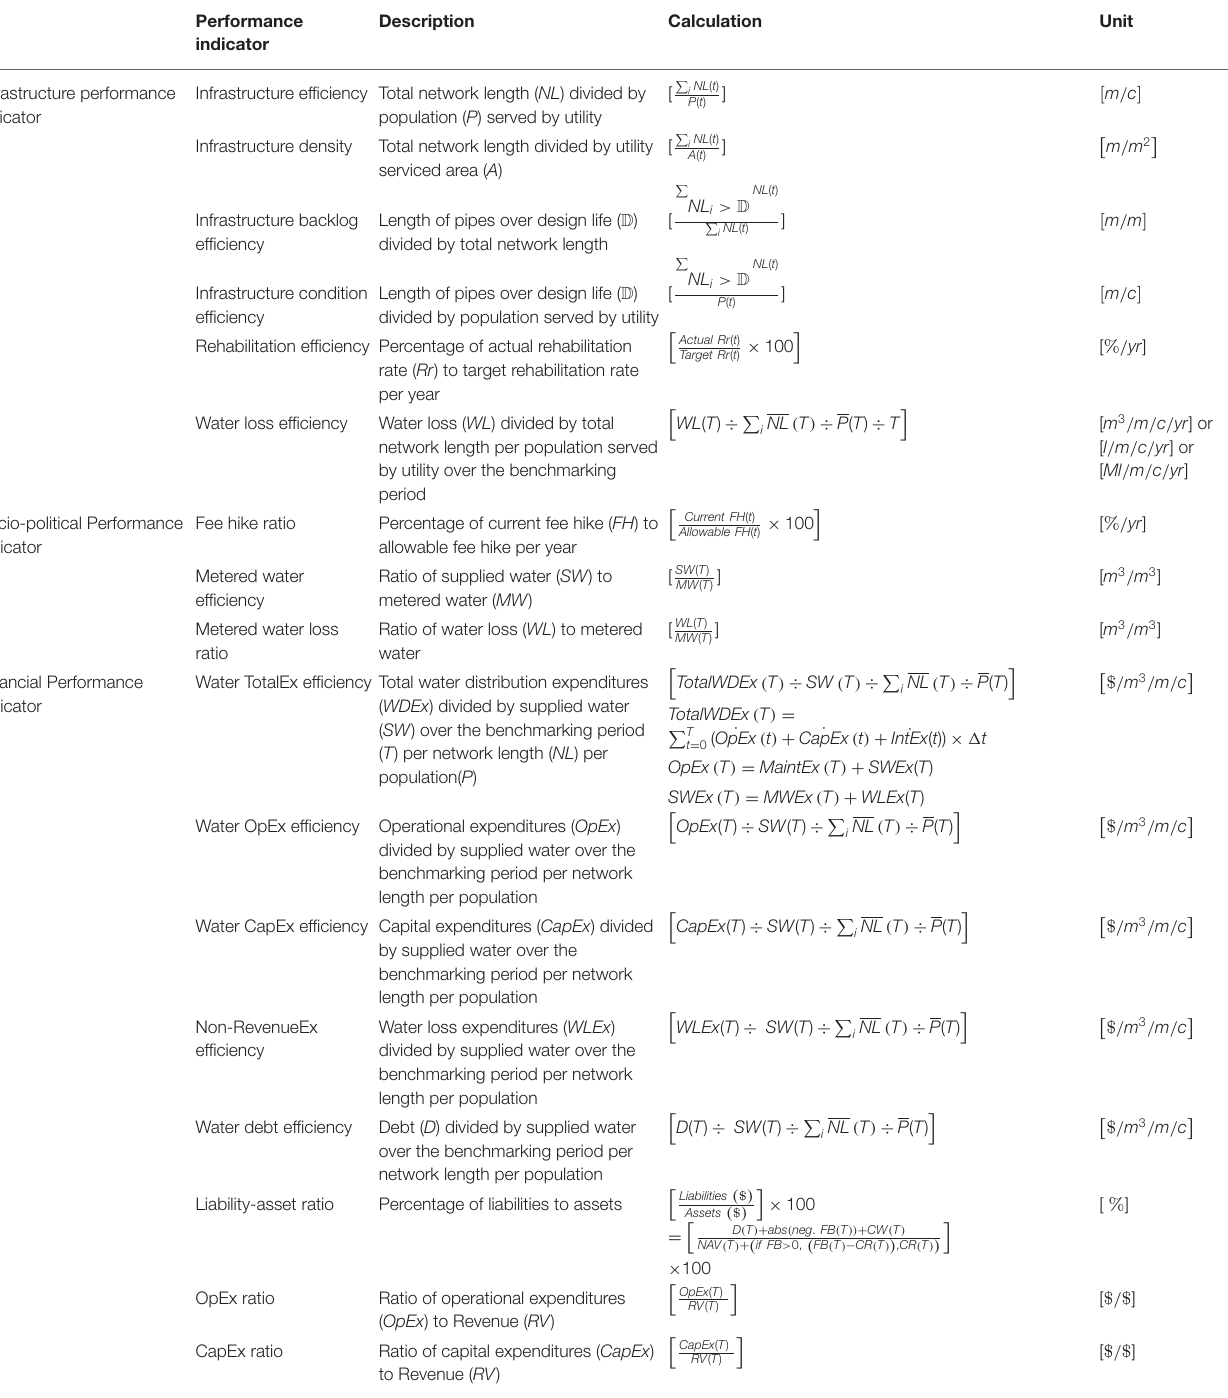
TABLE 1 | Benchmarking performance indicators for water distribution networks—adopted from Ganjidoost et al.